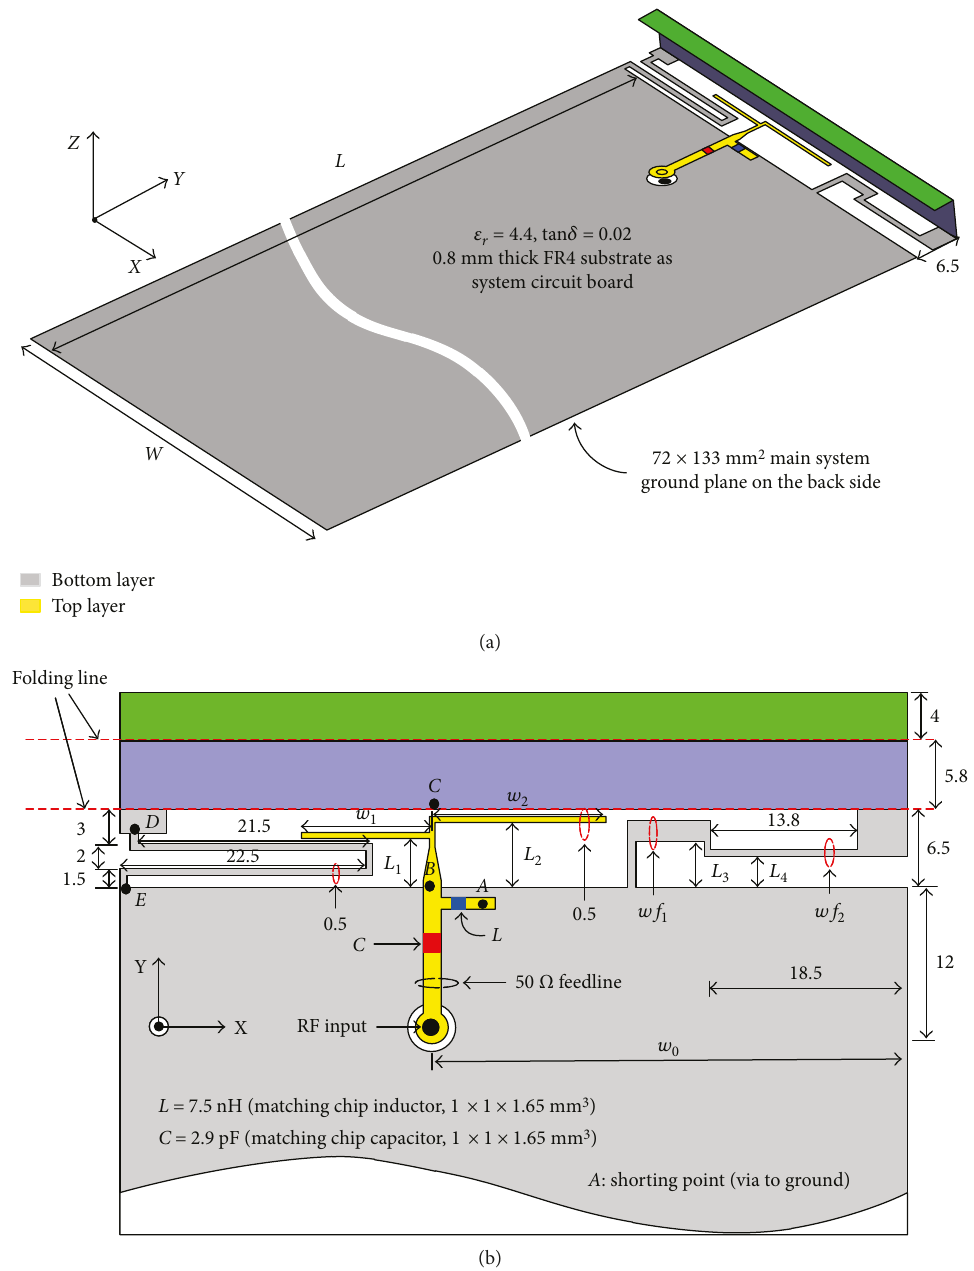
Figure 1: Geometry and dimensions of the proposed antenna. (a) Top view of the wideband antenna for Octa-band LTE/WWAN operation. (b) Enlargement dimensions of the metal pattern in the antenna area. L =133.5, W =72, w L =2.5, w f =1.7, w f =0.5, and w =43.5. Unit: 4 1 2 0